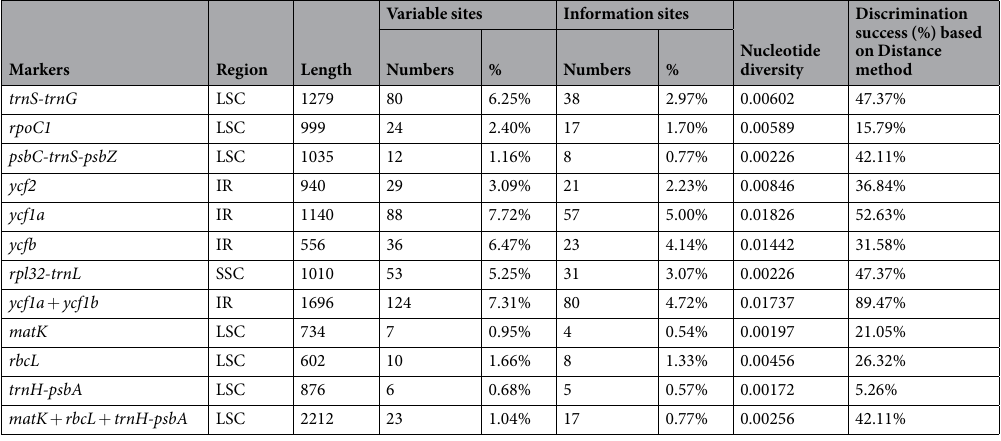
Table 2. Variability of the seven new markers and universal chloroplast DNA barcode in Paris